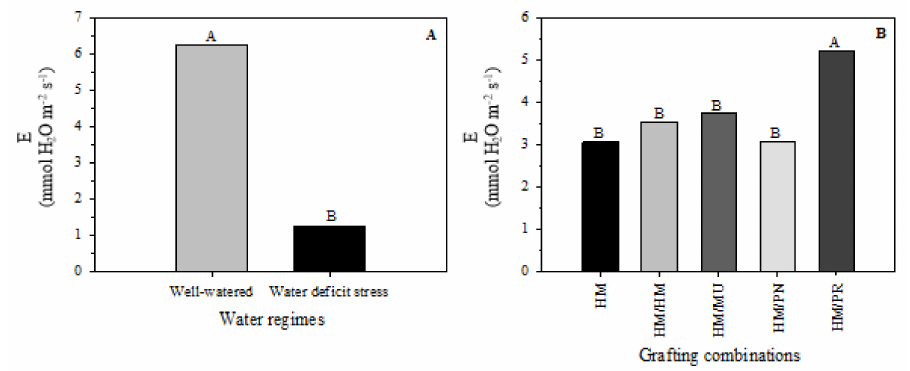
Figure 3. Leaf transpiration rate (E) of five grafting combinations ( B ) under well-watered and water- deficit stress conditions ( A ). Different letters denote significant differences between the water regimes and graft combinations according to the LSD test ( p ≤ 0.05). Note: HM = non-grafted HM 1823; HM/HM = HM 1823 self-grafted; HM/MU = HM 1823 grafted onto Multifort; HM/PN= HM 1823 grafted onto S. pennellii ; and HM/PR = HM 1823 grafted onto S. peruvianum